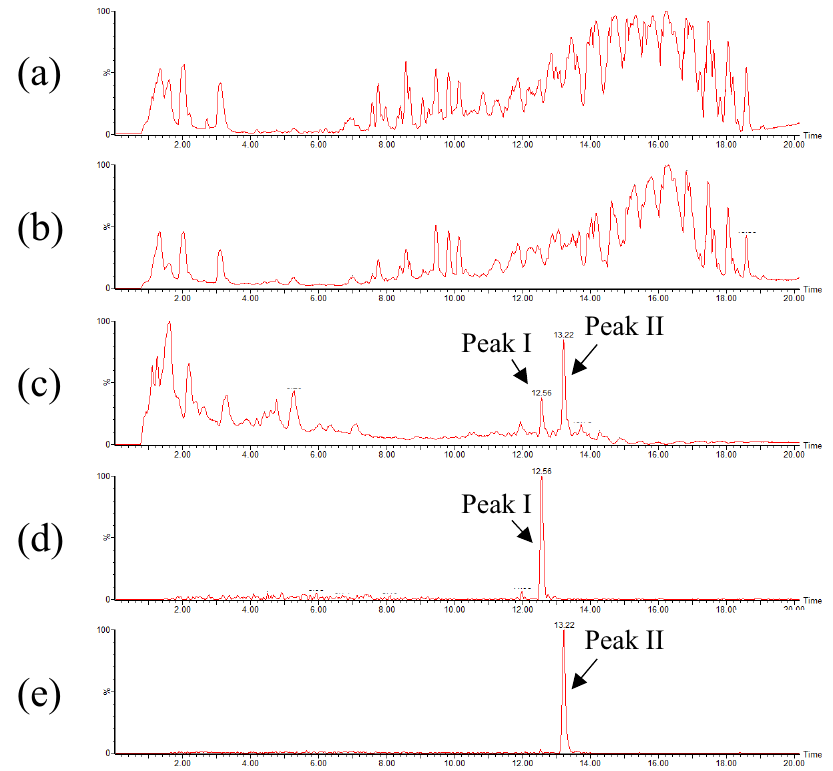
Figure 2. Typical chromatograms obtained during the UPLC-Tof/MS E analysis of ADAM-derivatized heated canola oil. The heating of canola oil was performed at 180 °C for 6 h. MS chromatogram ( a ). Product ion chromatogram without selection of the precursor ion ( b ). Extracted ion chromatogram of the product ion chromatogram without selection of the precursor ion ( c , at m/z 191.0861). Extracted ion chromatogram of the MS chromatogram ( d , at m/z 1001.6832 [M + Na] + ; and e , at m/z 1003.6985 [M + Na] + ). Each peak is annotated with the retention time.